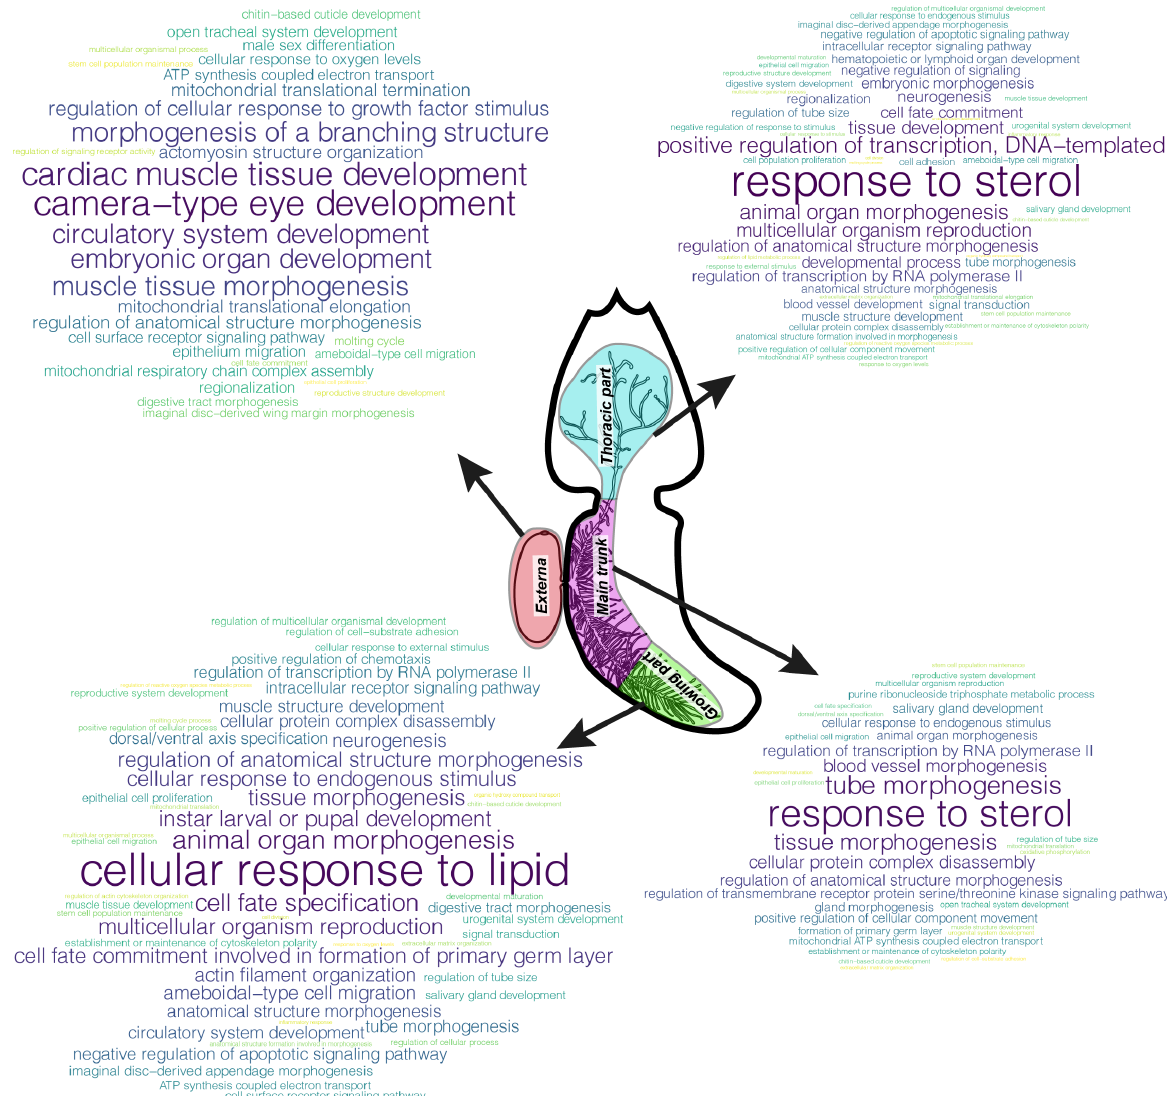
Figure 5. Gene set enrichment analysis (GSEA) results for top-500 annotated genes with the largest contribution to Transcriptome Age Index (TAI). Clouds of parental bioprocesses enriched with top-500 genes with both Gene Ontology (GO) annotation and large contribution to TAI of the body part under consideration. The more often the bioprocess was found in the list of enriched bioprocesses, the larger the word